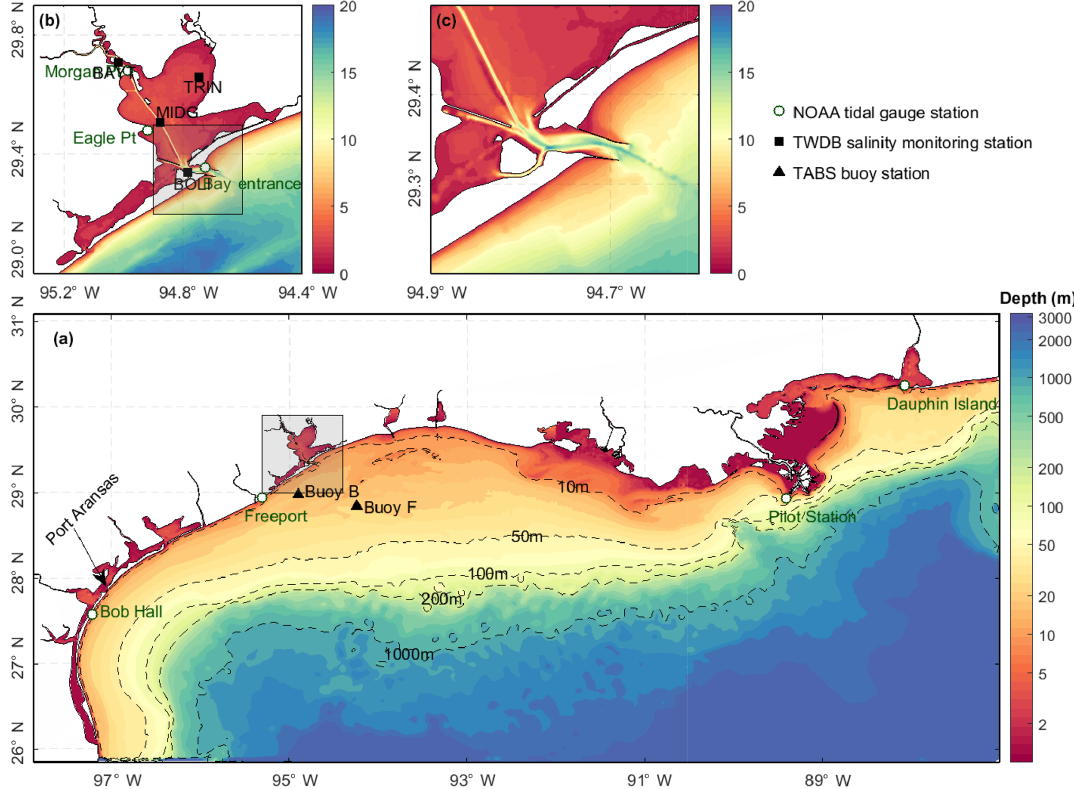
Figure 2. Bathymetry in the model domain showing zoomed-in views (b–c) of Galveston Bay and its main entrance. Note the log scale (a) for depth because of a very wide range of depth over the entire model domain. Also shown are the NOAA tidal gauge stations (open green circles), TWDB (Texas Water Development Board) salinity monitoring stations (solid black circles), and TABS (Texas Automated Buoy System) buoy stations (black solid